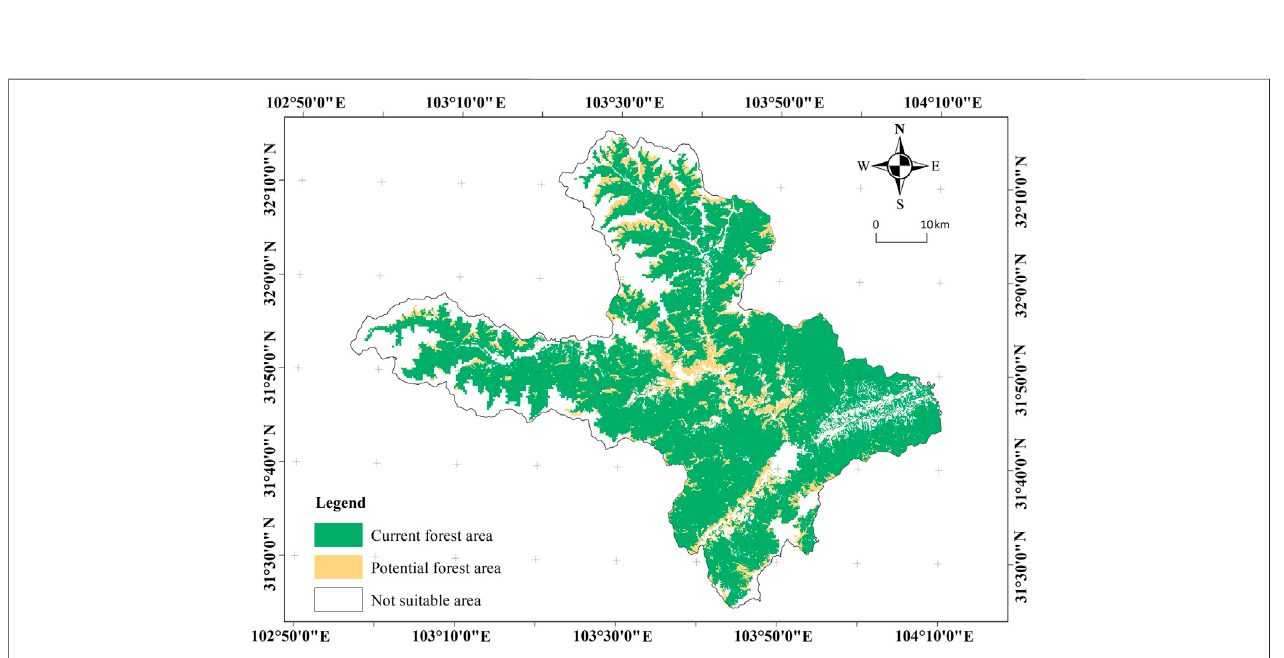
FIGURE 6 | Carbon sink potential distributions of the optimal scenario.